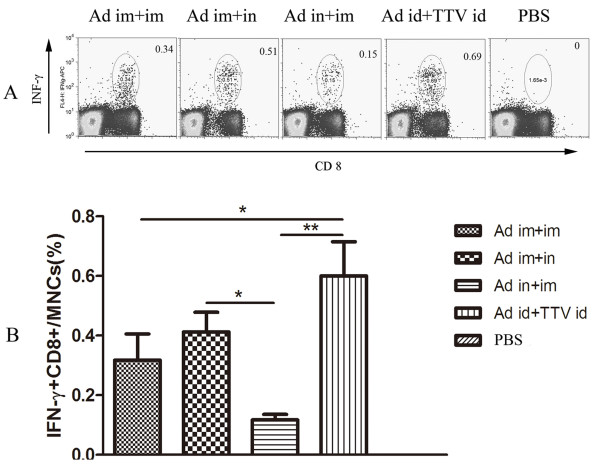
CD8+ T-cell response obtained by ICS in rAd5-CE1E2 and rTTV-CE1E2 immunised mice. Splenocytes isolated at week 20 were stimulated in vitro with peptide E1-21 (SQLFTFSPRRYETI) alone. Representative fluorescence-activated cell sorter flowgrams are shown in Figure 4A (percentages of IFN-γ+CD8+cells are shown in the right upper quadrants), and a summary of the percentages of IFN-γ-producing CD8+cells are presented in Figure 4B as the mean with SEM of four mice per group. Significant p values between the vaccinated groups are shown. * indicates p < 0.05, ** indicates p < 0.01.